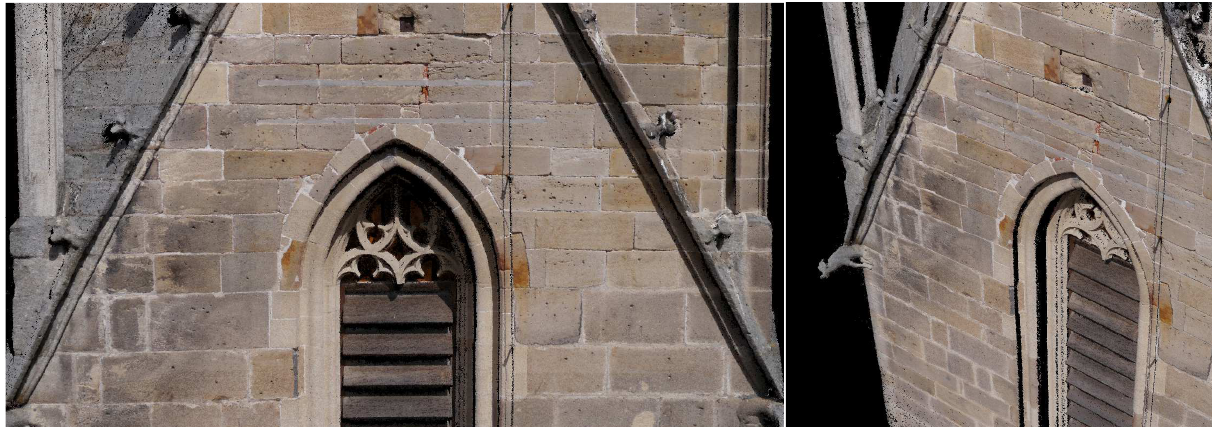
Fig. 4.3: Decision criterion for angles 8° (red), 16° (green) and 32° (blue). Dotted, black: overlap information. Line: theoretical distribution based on angle only. Dotted: effective distribution of criterion based on the angle including the overlap factor for Rottenburg example dataset.